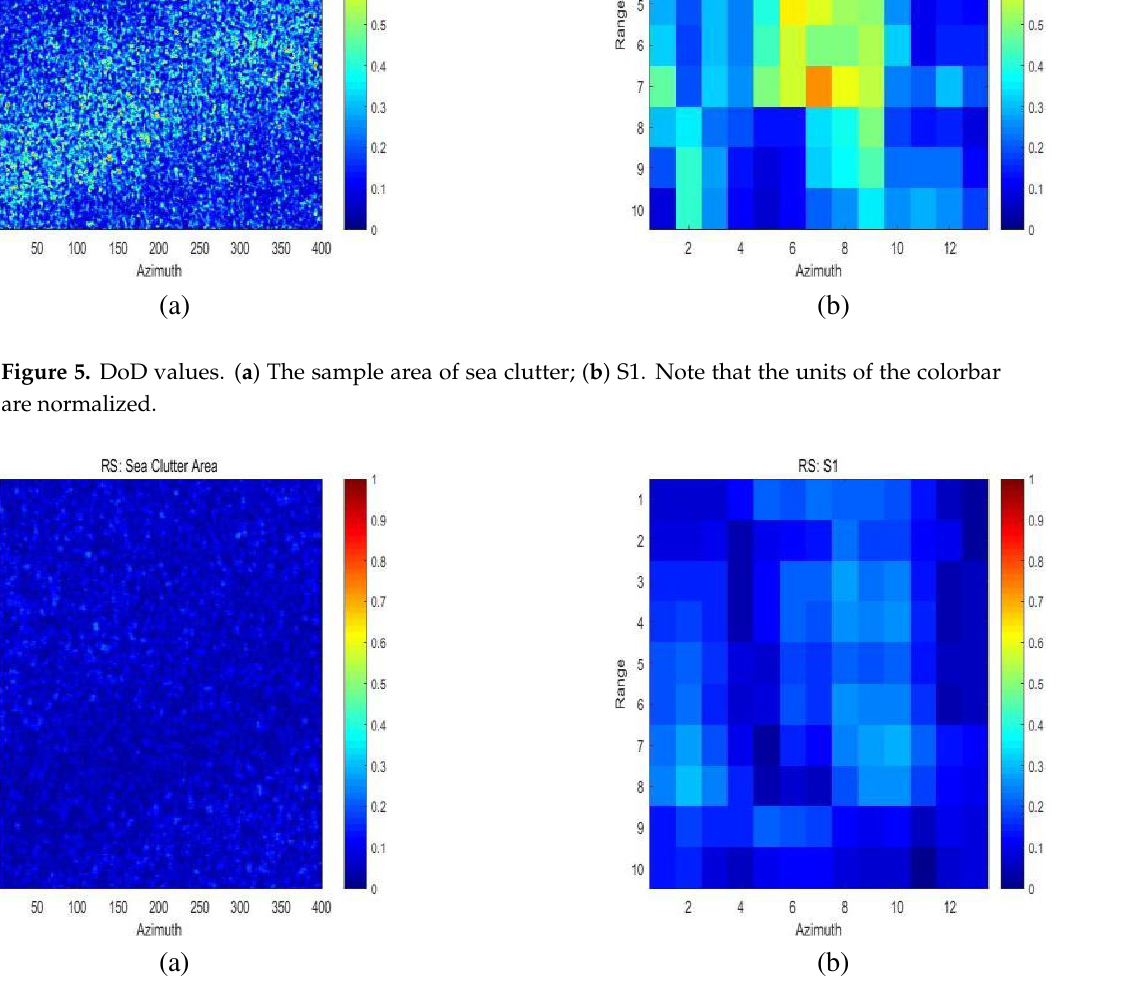
Figure 6. RS values. ( a ) The sample area of sea clutter; ( b ) S1. Note that the units of the colorbar are